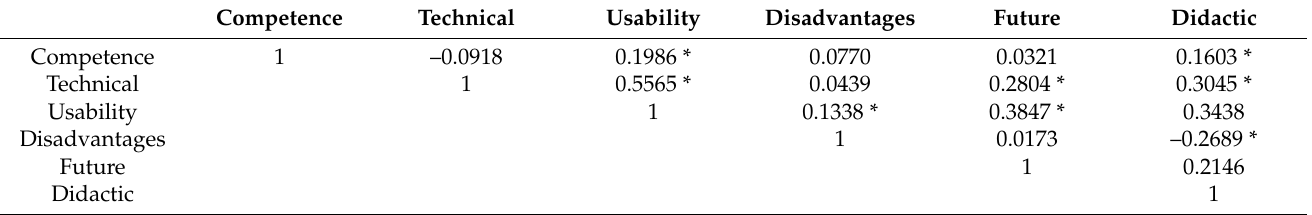
Table 4. Pearson correlations between the responses of the different families of questions, among the Health Sciences professors, with indication of those correlations that are statistically